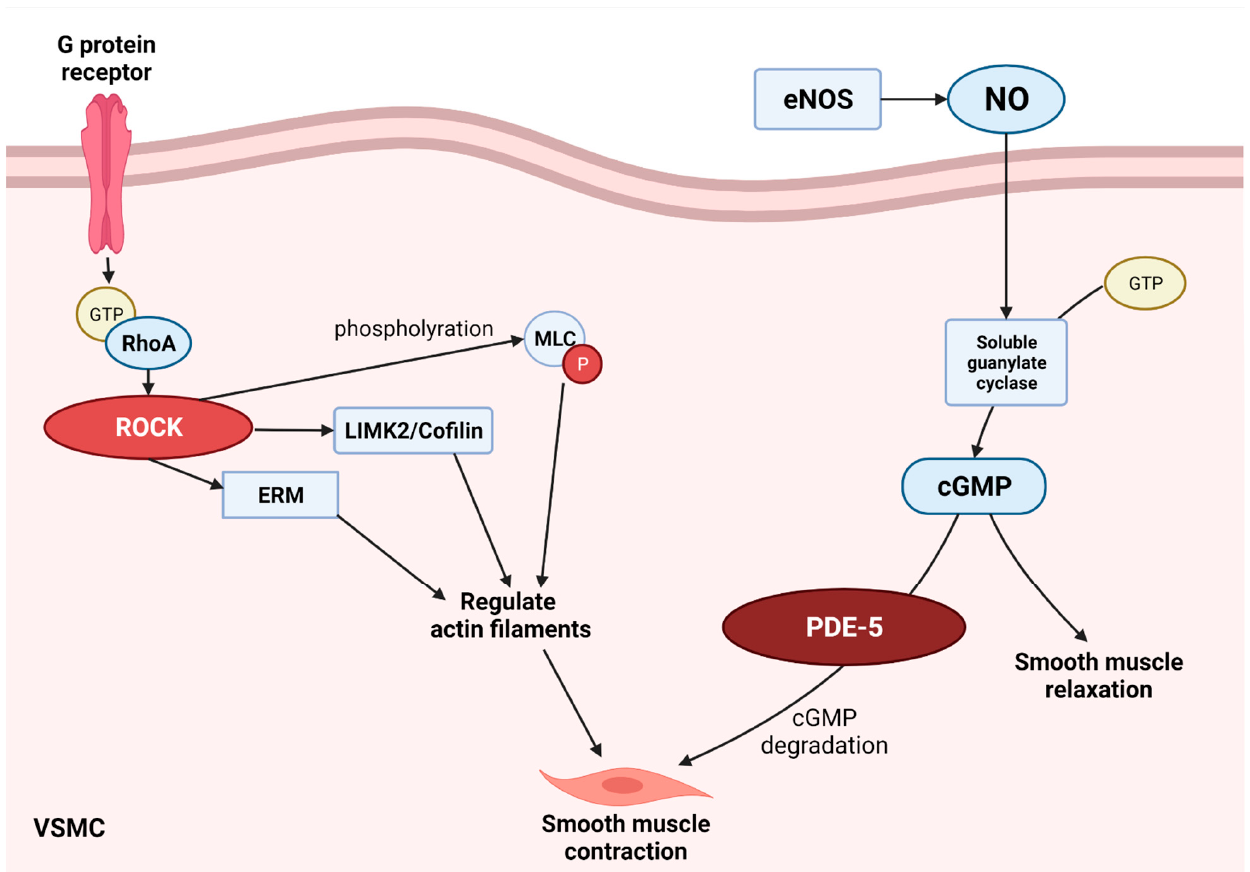
Figure 1. The RhoA/ROCK pathway and PDE-5 pathway contribute to smooth muscle contraction. ROCK prevents dephosphorylation of phosphorylated MLC and contributes to smooth muscle contraction by activating the LIMK2/cofilin pathway and the ERM pathway. PDE-5 decomposes increased cGMP from eNOS/NO, contributing to the contraction of VSMC. cGMP: cyclic Guanosine monophosphate; eNOS: endothelial nitric oxide synthase; ERM: ezrin/radixin/moesin; GTP: guano- sine triphosphate; LIMK: Lin11-Isl1-Mec3 kinase; MLC: myosin light chain; NO: nitric oxide; PDE-5: phosphodiesterase-5; ROCK: rho-associated protein kinase.